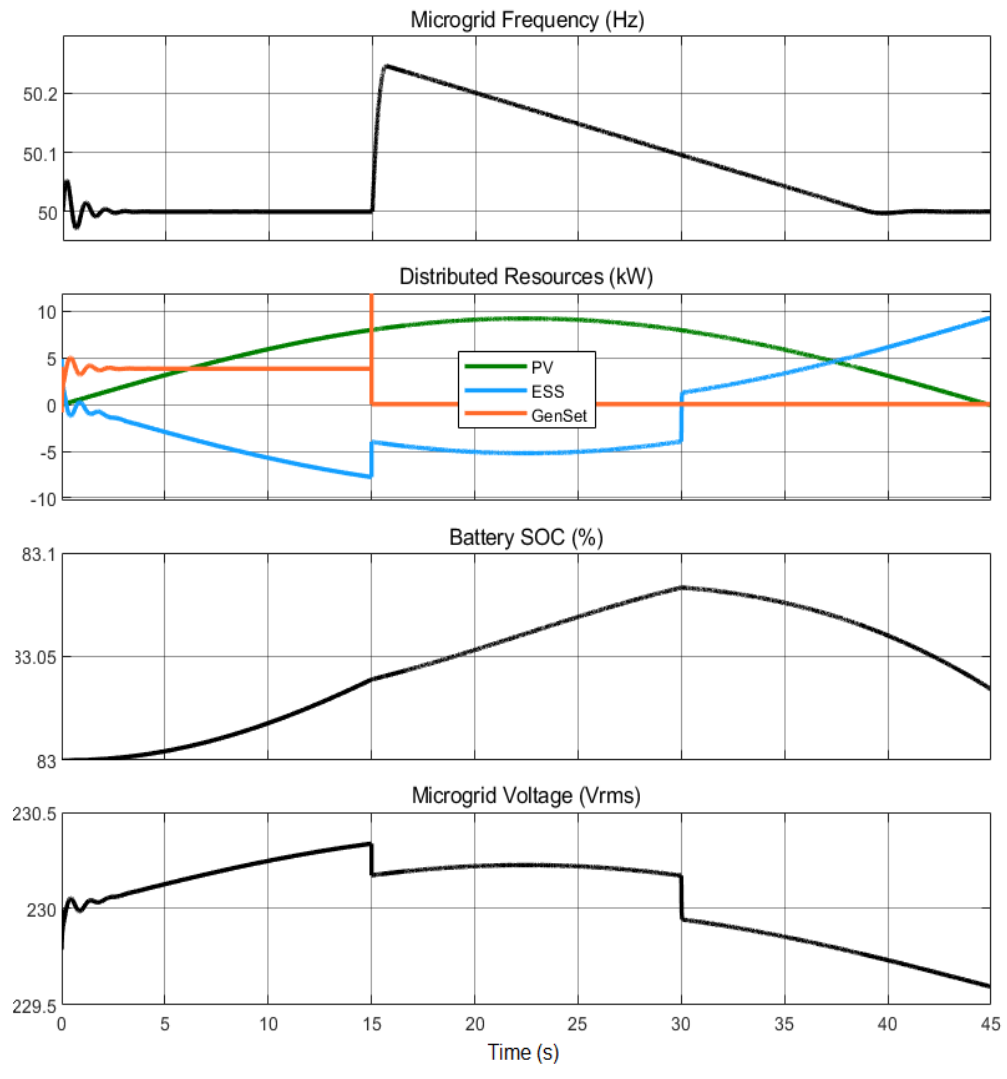
Figure 8. Real-time system response.